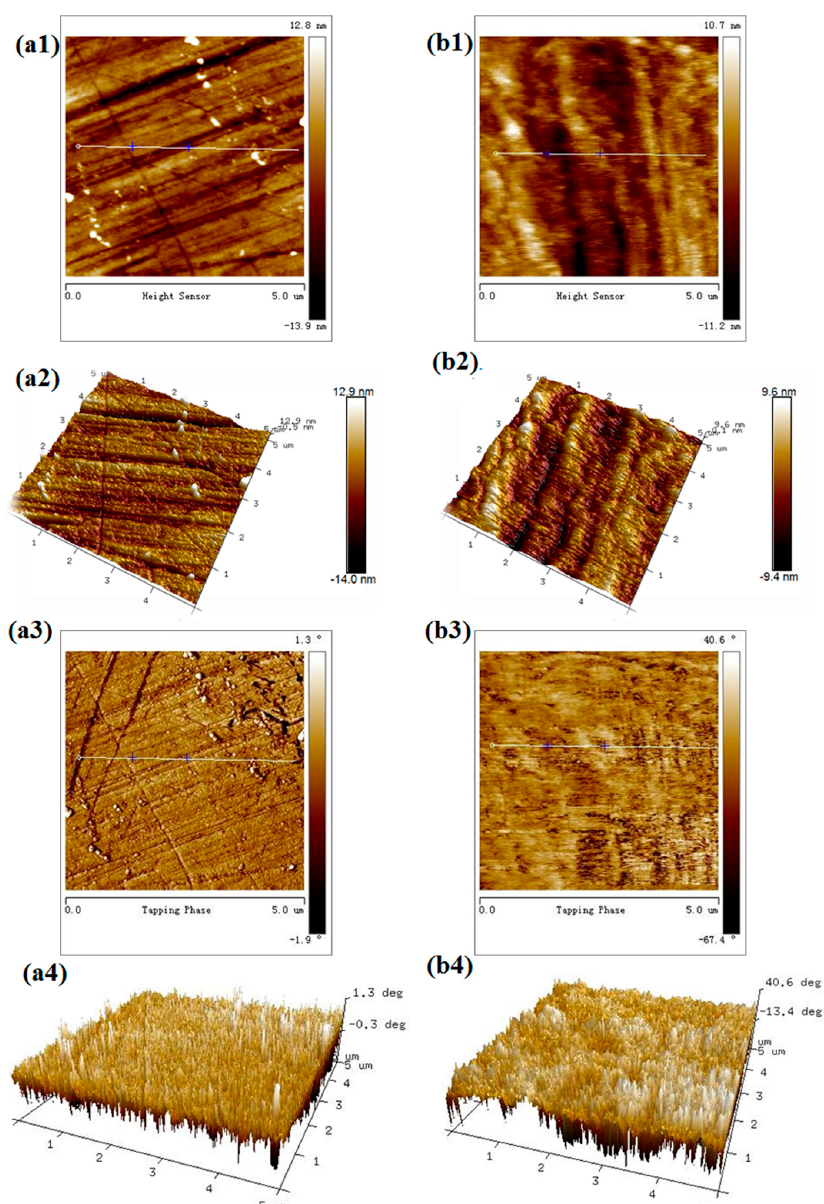
Figure 7. AFM 2D height ( a1 , b1 ), 3D height ( a2 , b2 ), 2D phase ( a3 , b3 ) and 3D phase ( a4 , b4 ) images of smithsonite treated with ( left ) 0 and ( right ) 10 − 2 mol / L Na 2 S solution.